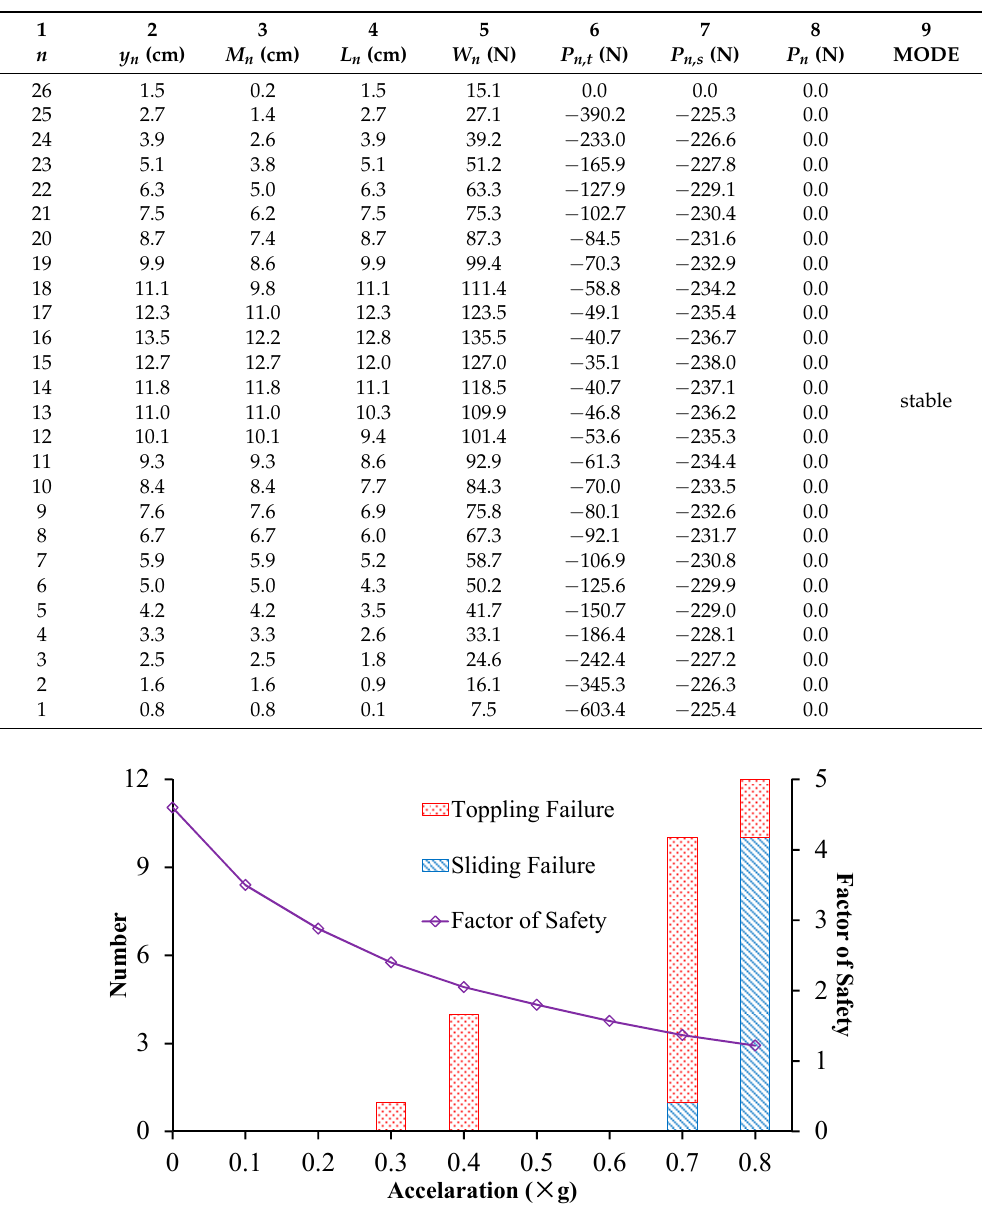
Table 3. The sheet from limit equilibrium analysis of slopes under static state.